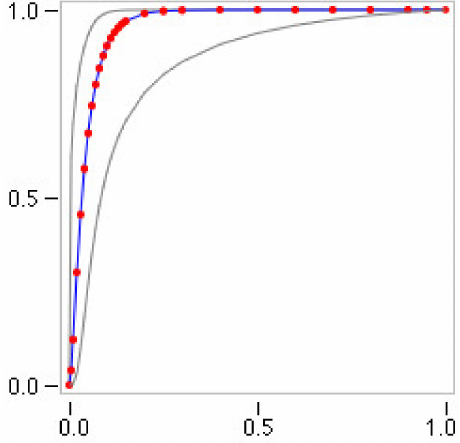
Figure 1. The ROC area of the first trained data: AUC (0.954).